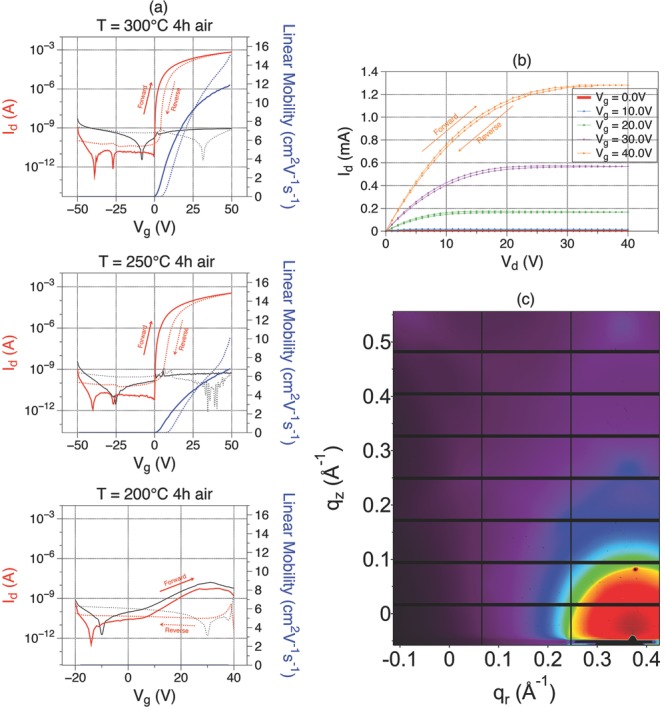
a) Red: drain current. Black: gate leakage current. Blue: Linear Mobility.
Solid lines represent forward scan. Dotted lines represent reverse scan.
Transfer curves for IZO (In2O3:ZnO = 6:4) TFTs
annealed in air for 4 h at different temperatures (Channel length/width
300/3000 μm; drain voltage Vd = 5 V).
b) Output curve for a device annealed in air for 4 h at 300 °C. c)
GIWAXS image for a ternary oxide film with composition
In2O3:ZnO = 6:4, which was annealed in air at
400 °C for 4 h.